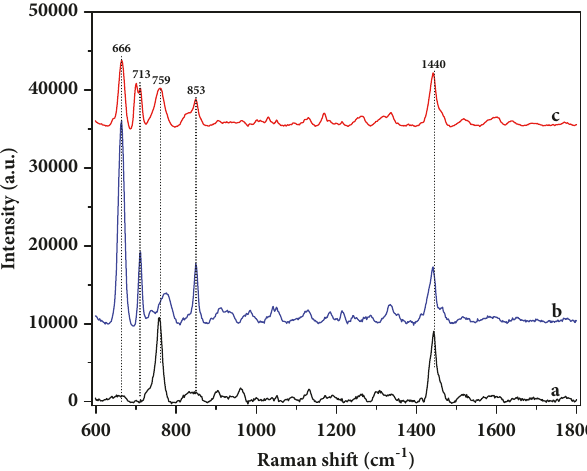
Figure 3: SERS spectra of gold nanorods (a), 100 mg/L of chlorme- quat chloride in methanol (b), and 20 mg/L of chlormequat chloride in wheat extraction solution